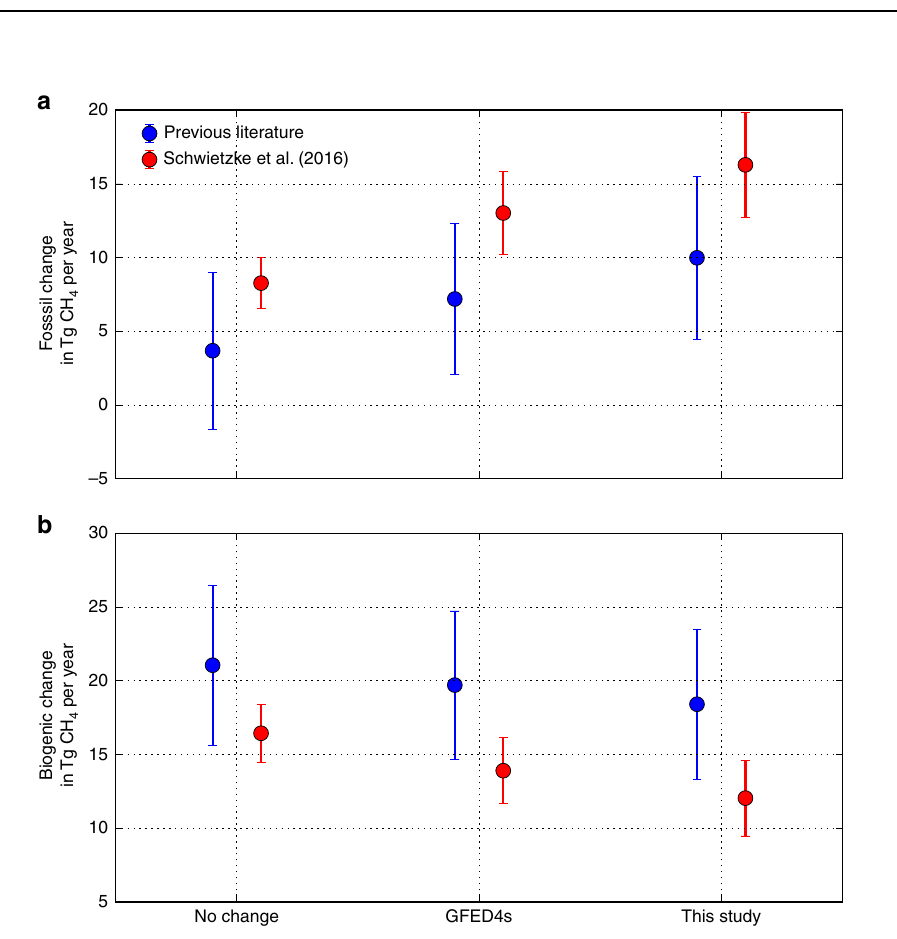
Fig. 4 Change in average annual biogenic and fossil fuel emissions. Change in average annual fossil fuel ( a ) and biogenic ( b ) emissions between the 2001 – 2006 and 2007 – 2014 periods needed to fi t the CH 4 mole fraction for different assumptions about biomass burning emissions and the isotopic signatures of the methane emission sources. These values are calculated for different proposed changes in biomass burning emissions: GFED4s = 2.1 ± 1.1 shown in Table 1. The error bars are the 1 σ uncertainties, which are calculated by propagating the uncertainties of the source isotopic signatures, biomass burning perturbations, and total perturbations needed to fi t the growth rate and isotope measurements (see iso-mf scenario in Fig.